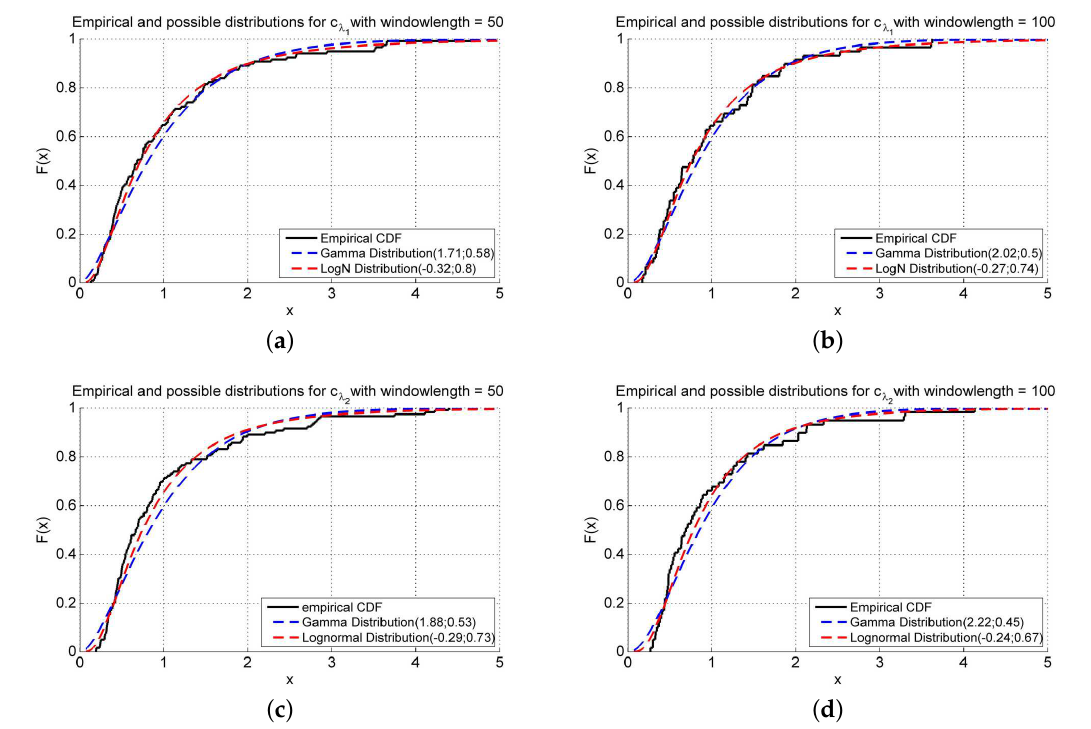
Figure 4. Possible and empirical distributions of c 1 and c 2 . ( a ) k 1 = 50; ( b ) k 1 = 100; ( c ) k 1 = 50; ( d ) k 1 =